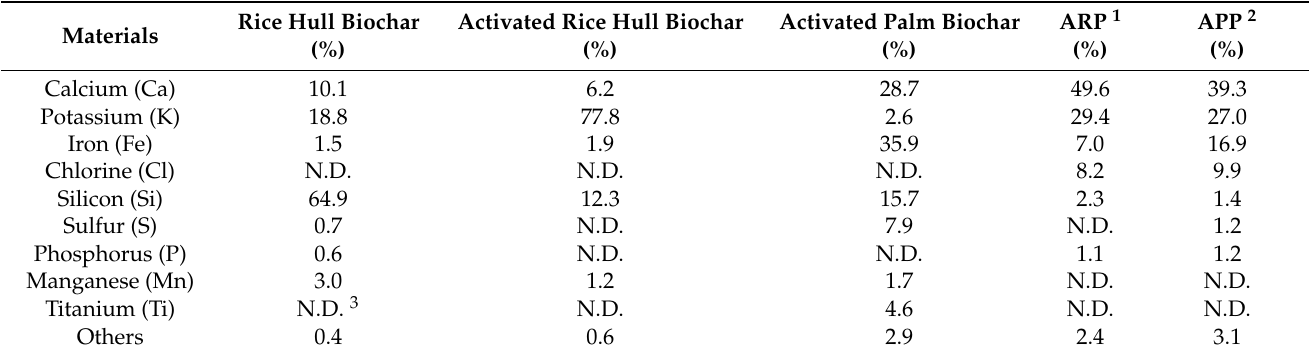
Table 2. XRF result of rice hull biochar, activated rice hull biochar, activated palm biochar, and their manure compost pellet materials.